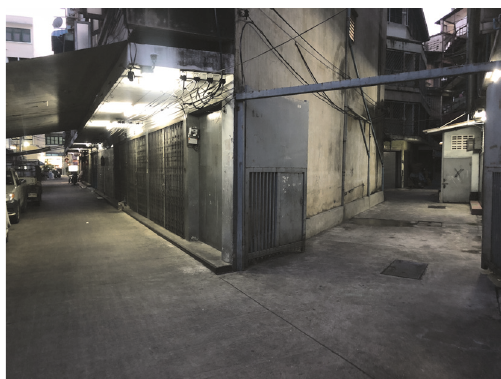
Figure 1: Sample building that causes blind